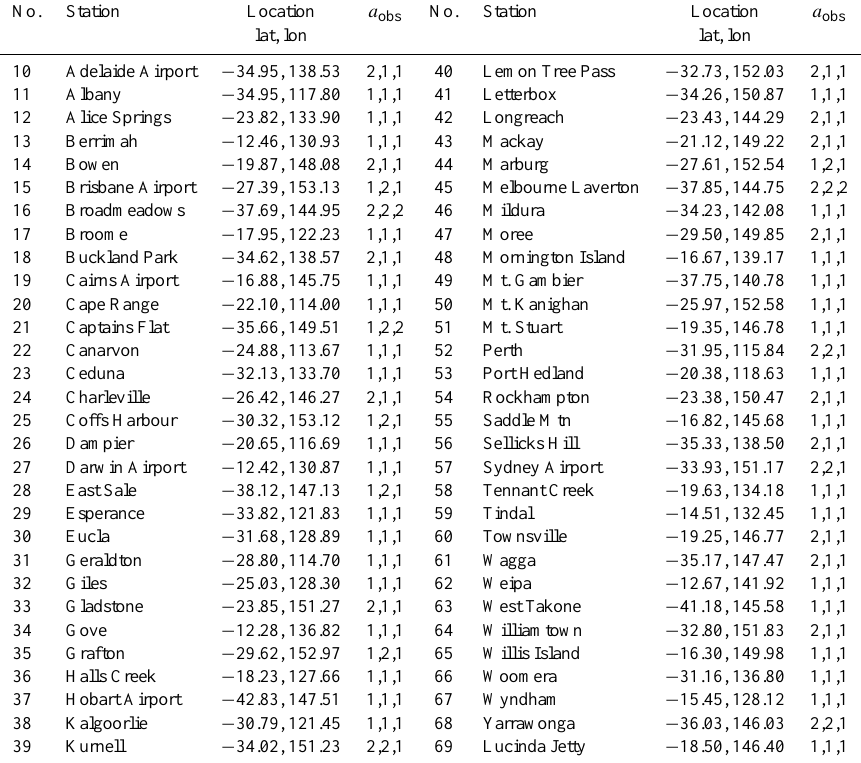
Table 2. Location of potential greenhouse gas measurement stations using the location of the Bureau of Meteorology weather watch radar stations including one additional station at Lucinda Jetty. The factor a obs is used to scale the observational uncertainties for CO 2 , CH 4 and N 2 O in a sensitivity